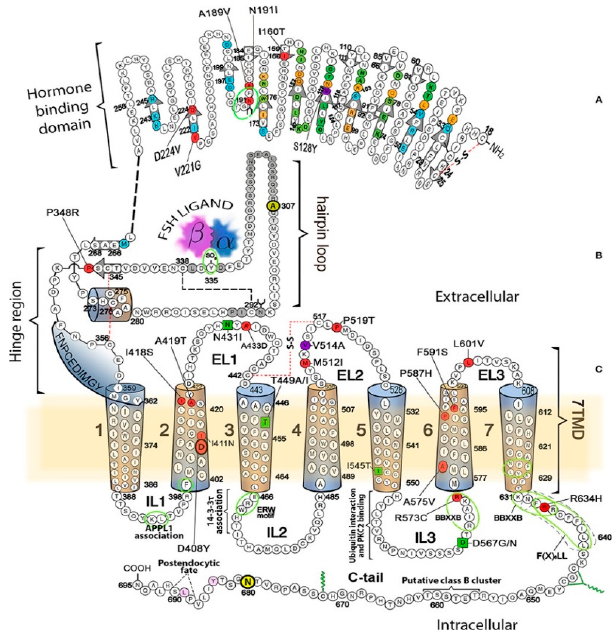
Figure 2. Structure of the follicle-stimulating hormone receptors (FSHRs) showing the hormone-binding domain, hinge region, seven transmembrane segments, and the intracellular C terminus. Mutations to amino acids shaded in red lead to the FSHRs loss of function [21]. This figure was reprinted from [21] under the terms of the Creative Commons Attribution 4.0 License.